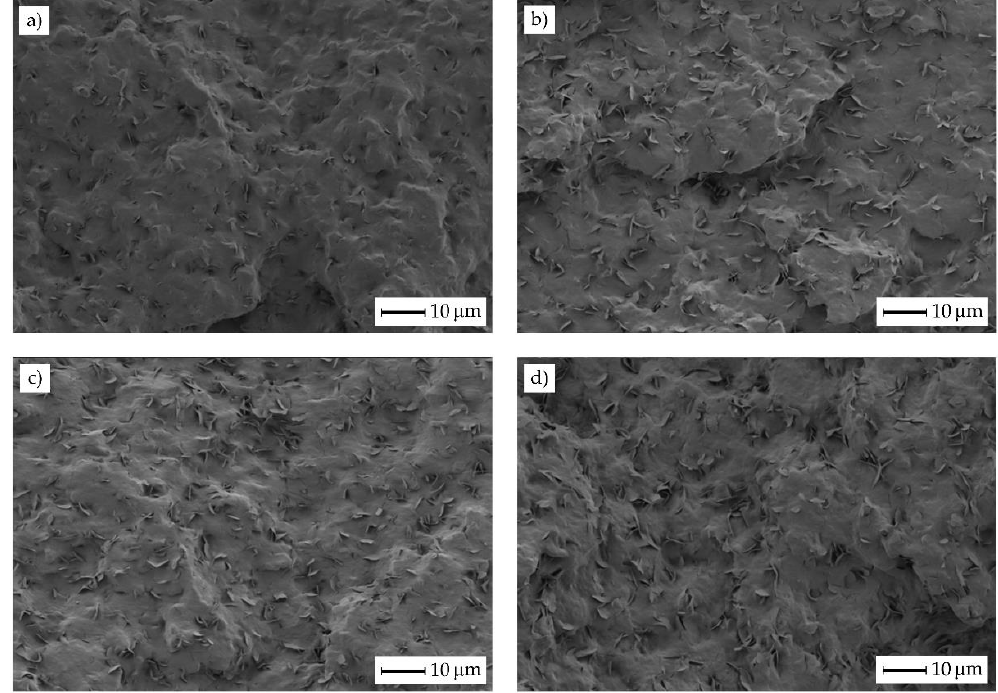
Figure 5. Field emission scanning electron microscopy (FESEM) images at 1000 × of the impact fracture surface morphologies of PHBH/PCL binary blends with different PCL wt %, ( a ) 10, ( b ) 20, ( c ) 30, and ( d ) 40.